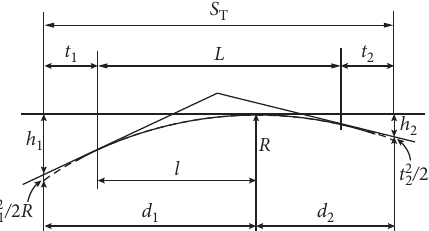
Figure 6: Calculation scheme of convex a vertical curve ( L ≥ S T ).